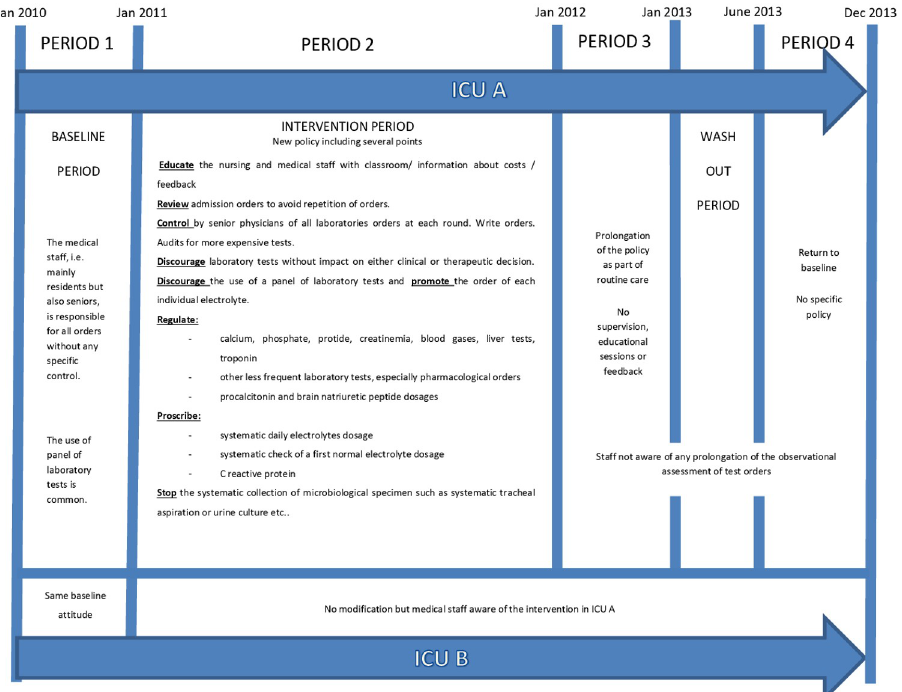
Fig 1. Characteristics of interventions according to different